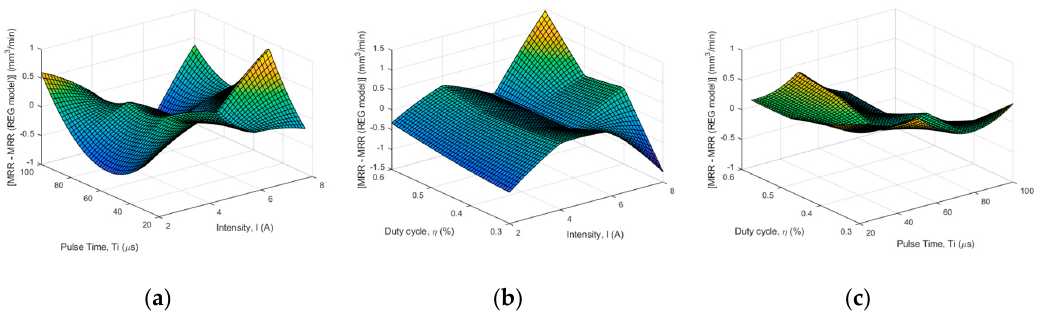
Figure 8. Di ff erence between MRR (FIS model) and MRR (regression [2]) vs.: ( a ) Pulse Time and Figure 8. Difference between MRR (FIS model) and MRR (regression [2]) vs.: ( a ) Pulse Time and Intensity; ( b ) Duty cycle and Intensity; ( c ) Duty cycle and Pulse Intensity; ( b ) Duty cycle and Intensity; ( c ) Duty cycle and Pulse Time. Figure 8. Difference between MRR (FIS model) and MRR (regression [2]) vs.: ( a ) Pulse Time and Intensity; ( b ) Duty cycle and Intensity; ( c ) Duty cycle and Pulse Time. Figure 8. Difference between MRR (FIS model) and MRR (regression [2]) vs.: ( a ) Pulse Time and Intensity; ( b ) Duty cycle and Intensity; ( c ) Duty cycle and Pulse Time.